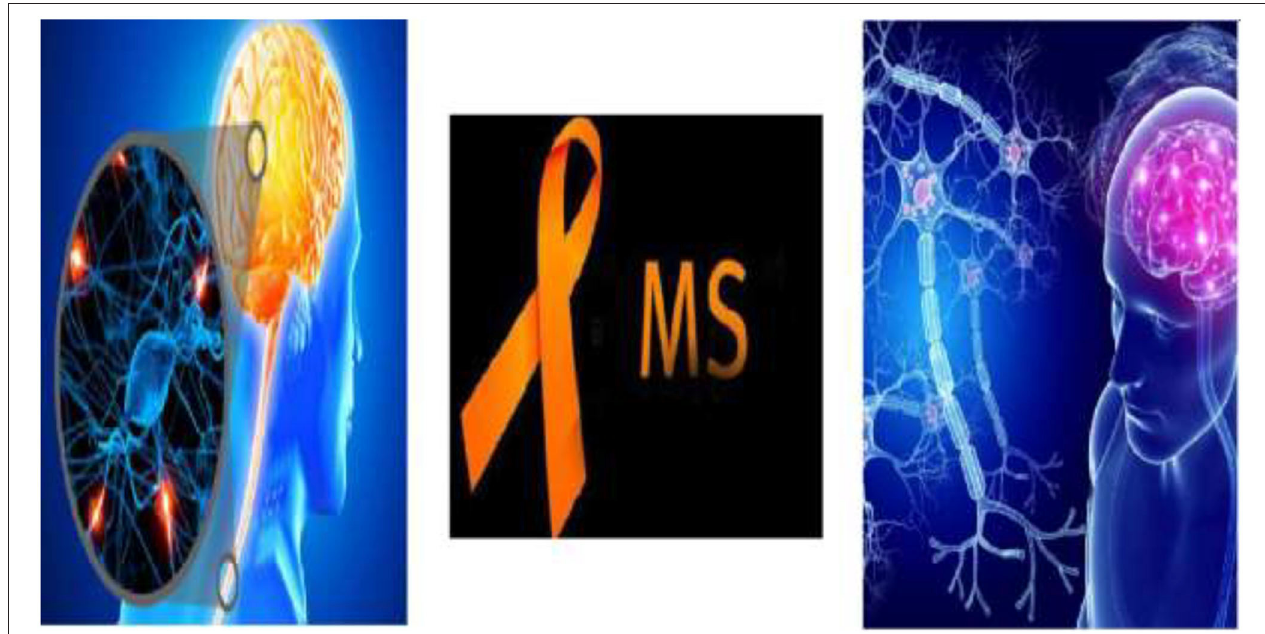
FIGURE 2 | Immune system attacks the nerve tissue (multiple